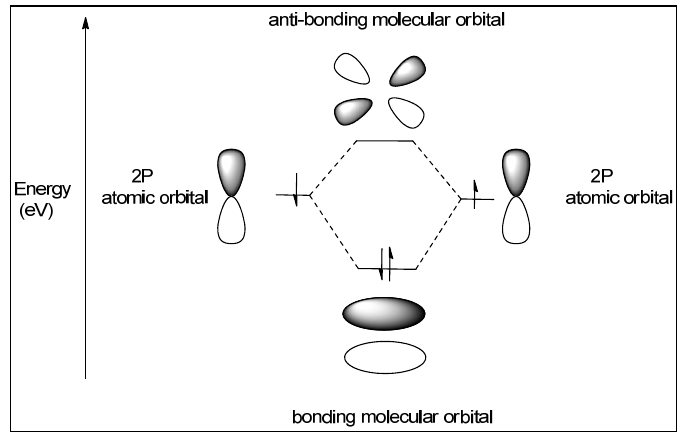
Figure 2. The diagram of molecular orbitals showing the formation of π - and π *-bonding orbitals. The differences in these energy levels generate π -bands (commonly known as